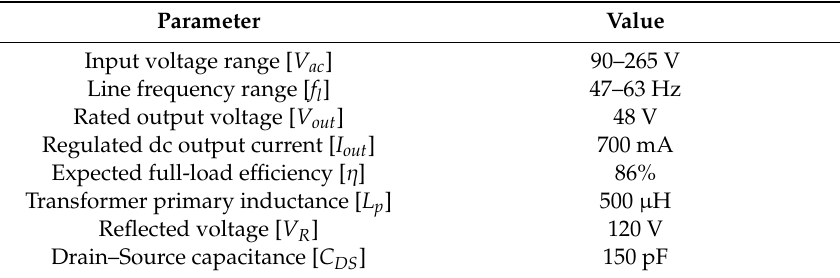
Table 1. Main characteristics of the Hi-PF QR flyback